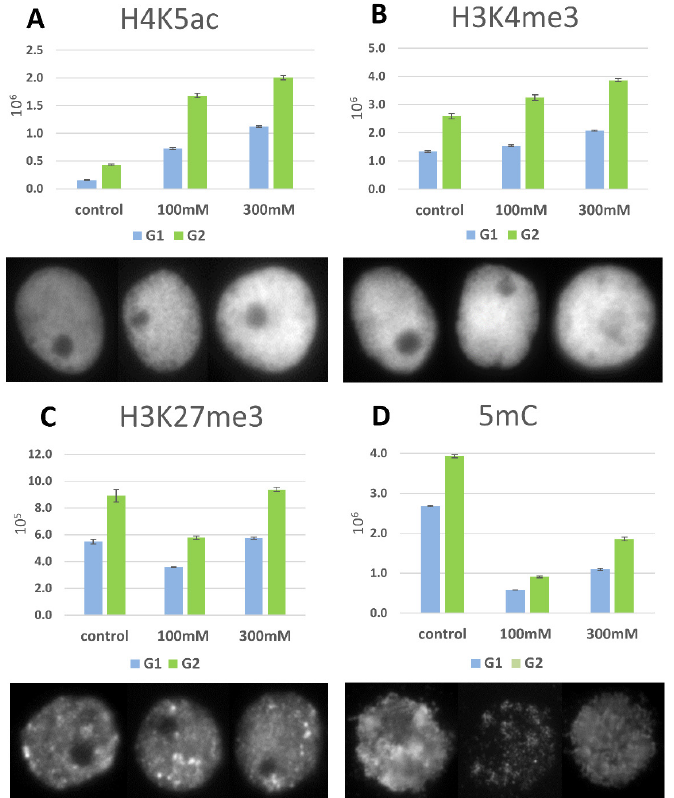
Figure 10. Levels of the relative Alexa 488 fluorescence intensities for the modified histones H4K5ac ( A ), H3K4me3 ( B ), H3K27me3 ( C ) and 5-methylcytosine (5 mC) ( D ) as well as for the im- munostaining of representative interphase nuclei in the root cells of the Brachypodium seedlings that had been “salt-shocked” with 100 mM and 300 mM NaCl. The values are shown as the aver- age values ± SE.